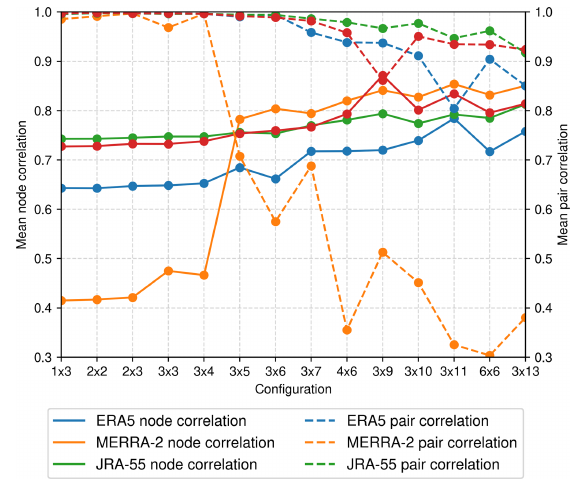
Figure B1. Indicators of SOM realism and node uniqueness for different configurations (grid sizes). Solid lines are the mean node correlation and dashed lines the mean pair correlation for Casey (green), DDU (red), Mawson (blue) and Neumayer